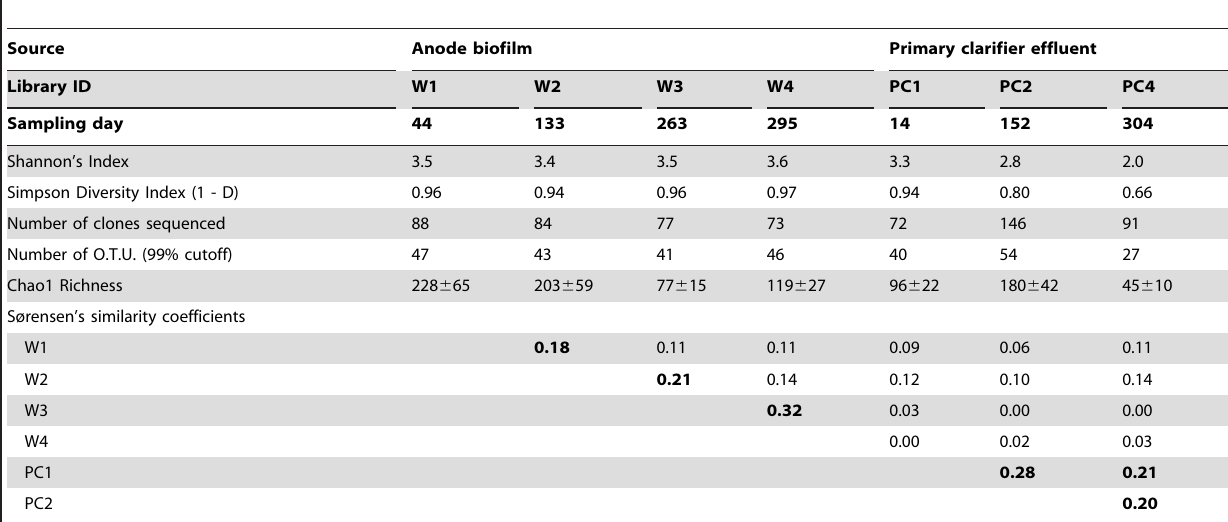
Table 2. Diversity statistics and recovery of bacterial phyla from MFC anode biofilms and primary clarifier effluents.